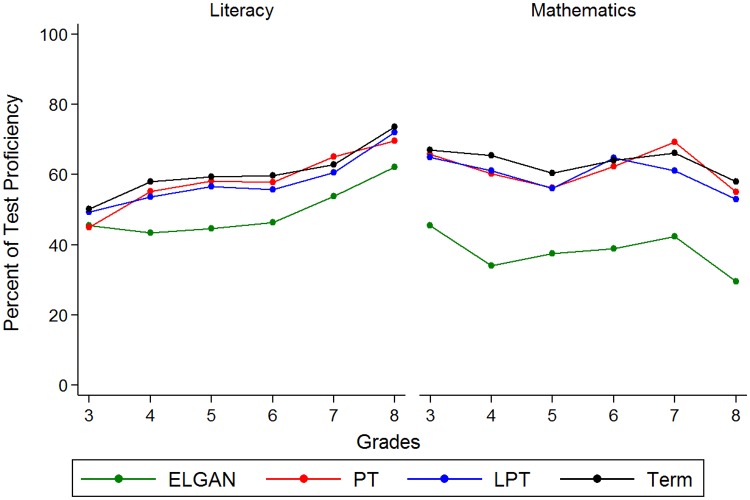
Literacy and mathematics test proficiency by gestational age group and grade level.